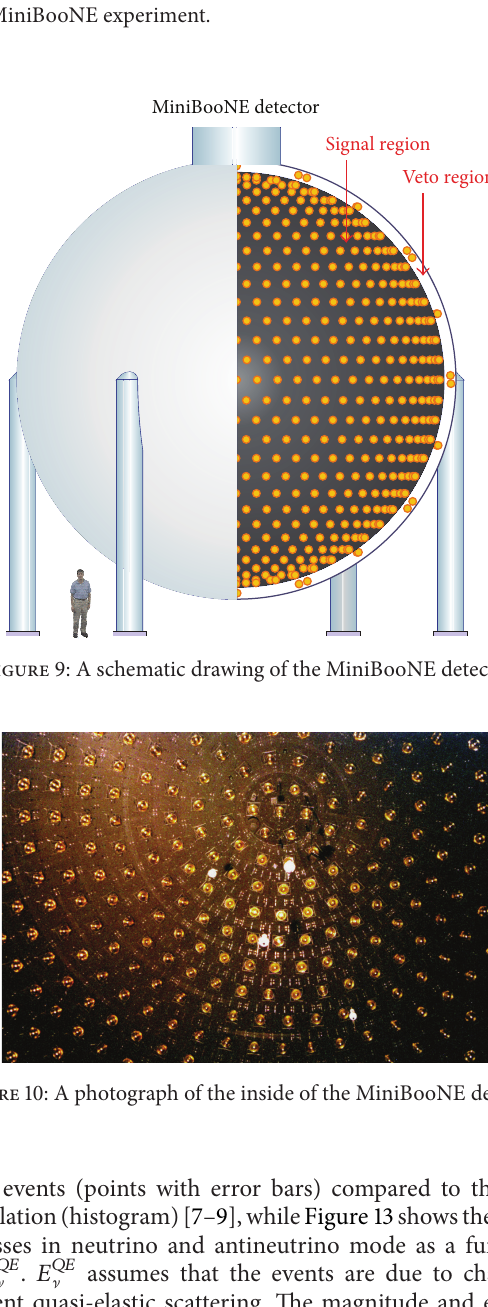
Figure 8: A schematic drawing of the MiniBooNE experiment.